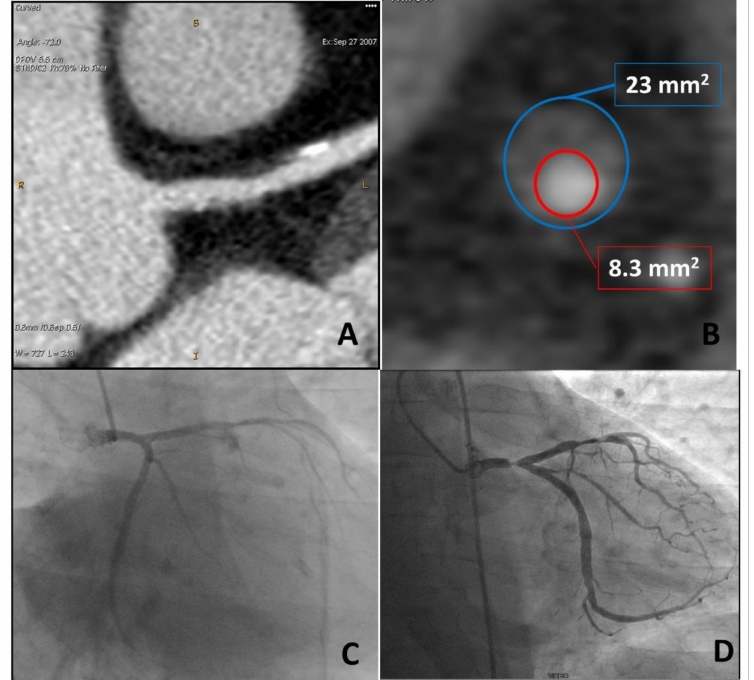
Figure 5. A 51-year-old man underwent CCTA on September 2007 for suspected CAD that showed only moderate lesions (panel ( A )), with high-risk features on distal left main (positive remodeling and low-attenuation plaque, panel ( B )). Invasive coronary angiography was performed due to typical anginal symptoms, and no significant diseases were identified (panel ( C )). In July 2012, the patient’s non-ST elevation myocardial infarction (NSTEMI) and progression to subocclusive disease on the left main was identified as the culprit lesion (panel ( D